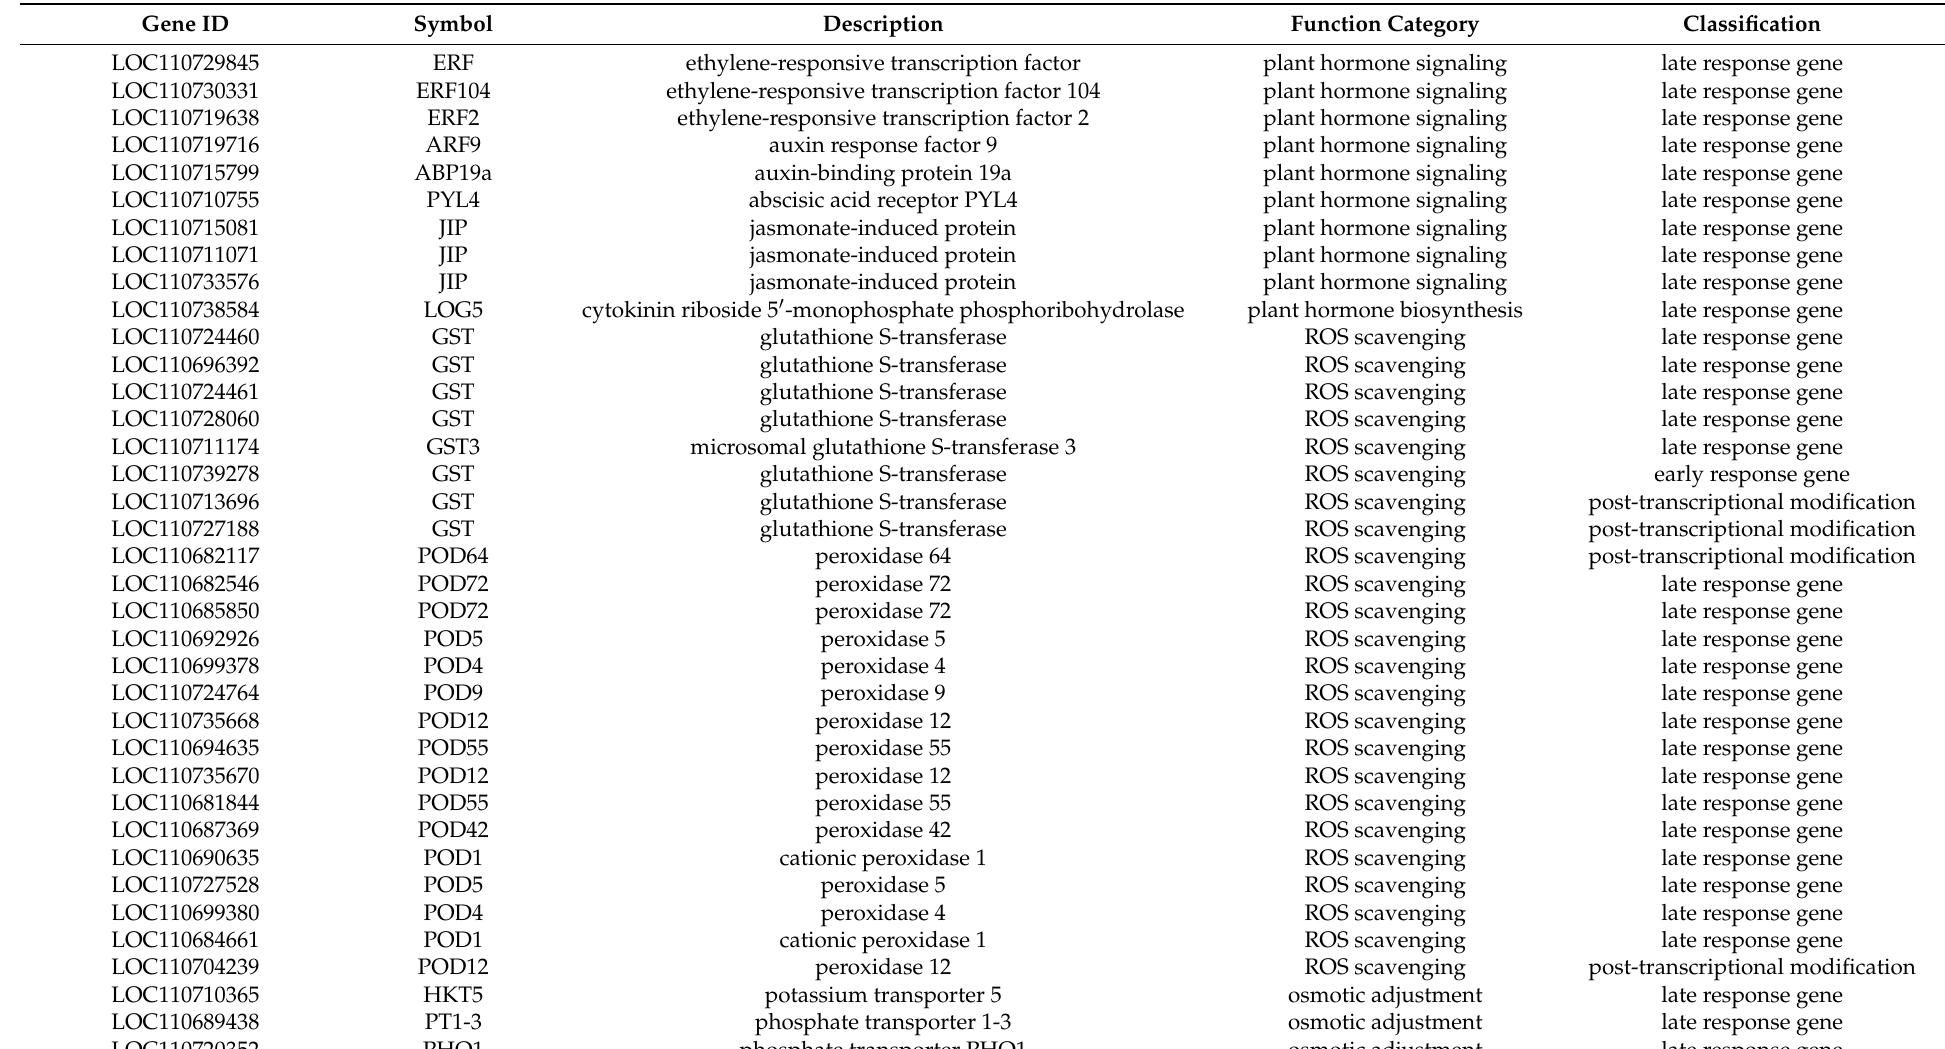
Table 2. A summary of candidate proteins/genes in ethylene and salt responses of